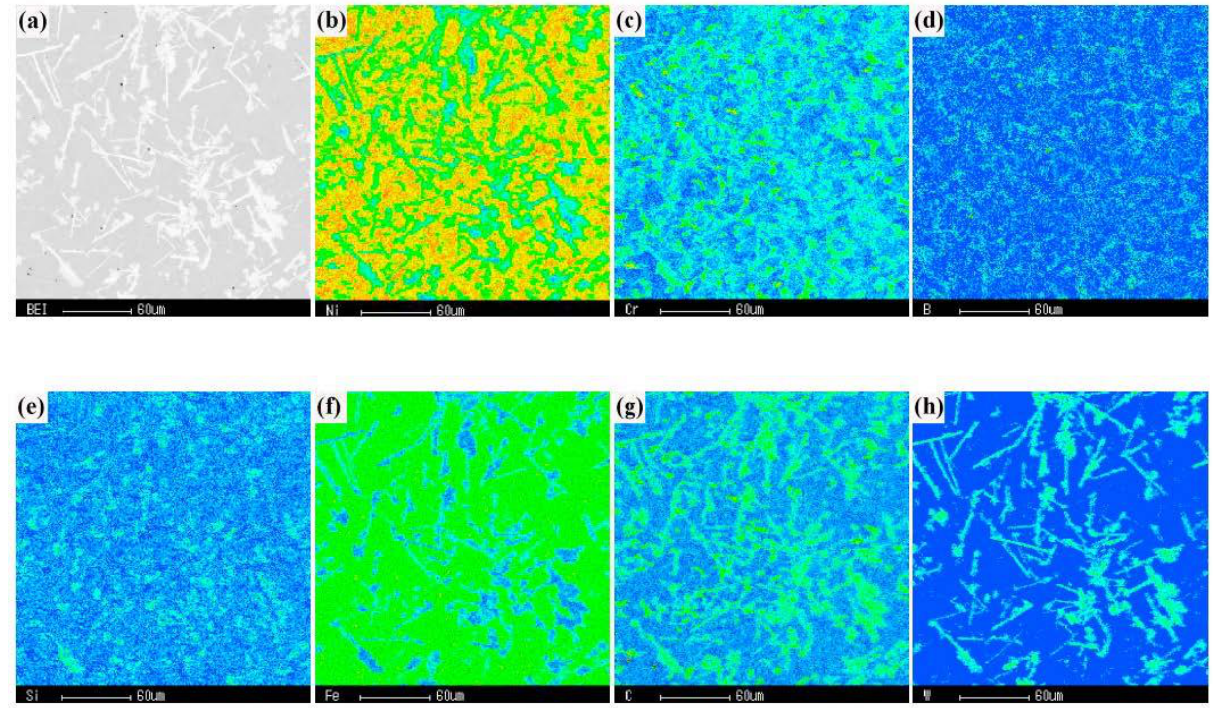
Figure 7. Elemental mapping of the acicular constituent of sample C ( a ) BEI; ( b ) Ni; ( c ) Cr; ( d ) B; ( e ) Si; ( f ) Fe; ( g ) C; ( h )